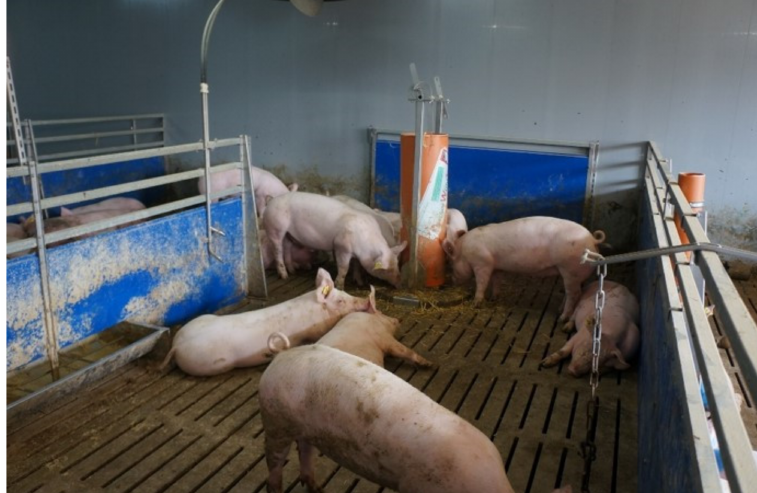
Figure 4. Pigs in a pen equipped with the interactive tower. Table 2. Modified German scoring system (Schwarzenauer key) used for assessing pig tails for injuries and losses [40,41].